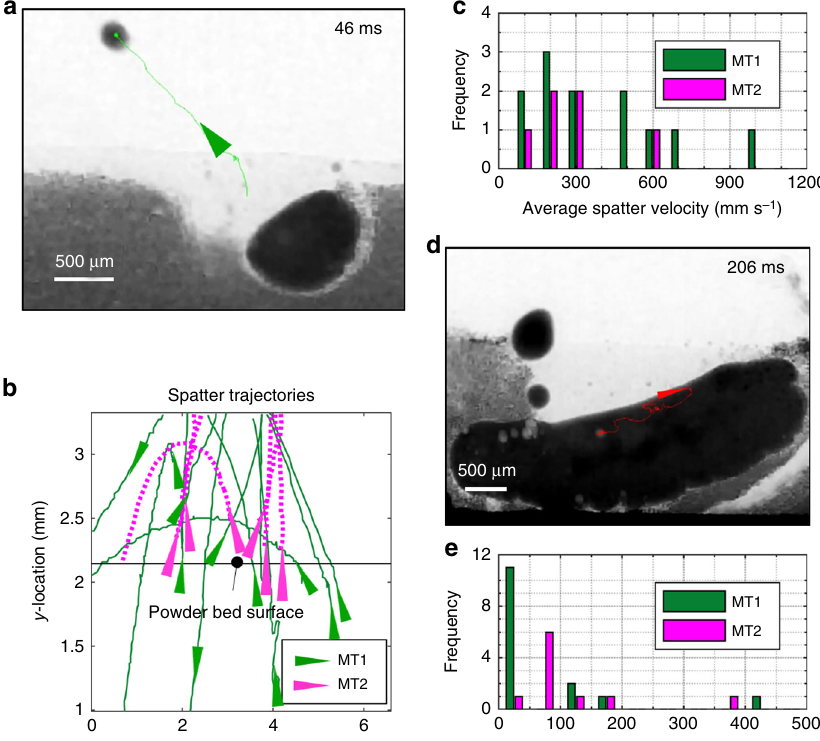
Fig. 4 Tracking the movement of spatter and pore during LAM of the two melt tracks (MT1 and MT2). a An example of a spatter trajectory overlaid on a radiograph (see the spatter tracking video in Supplementary Movie 6). b An overlay image contains all the spatter trajectories. c A histogram of the average spatter velocities. d An example of a pore fl ow trajectory overlays on a radiograph. The centrifugal Marangoni-driven fl ow forces the pore to fl ow in a clockwise direction (see the pore tracking video in Supplementary Movie 7). e A histogram of the average pore fl ow